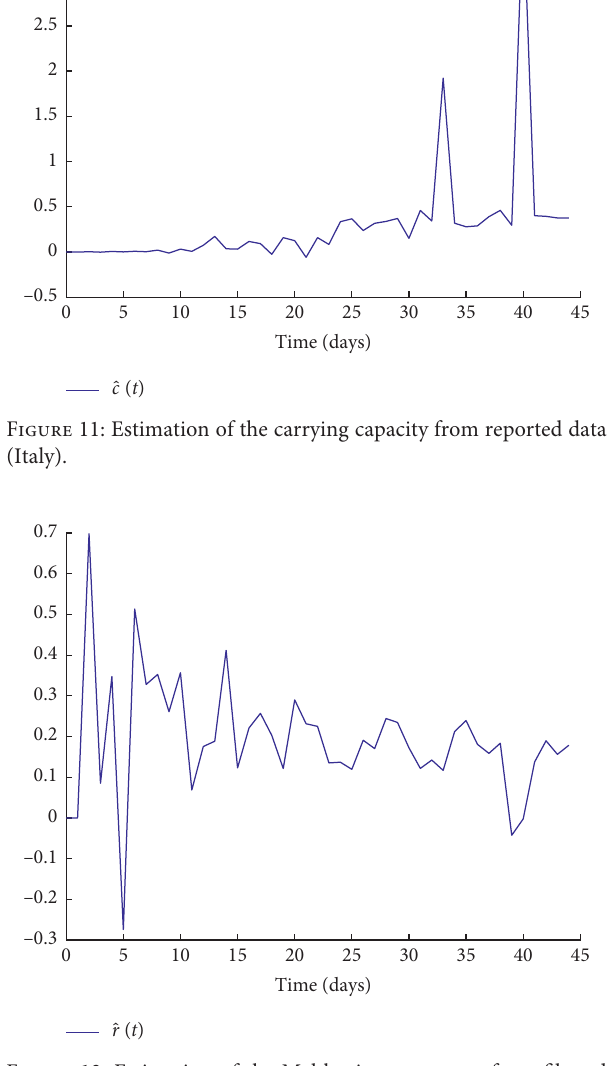
Figure 12: Estimation of the Malthusian parameter from filtered reported data